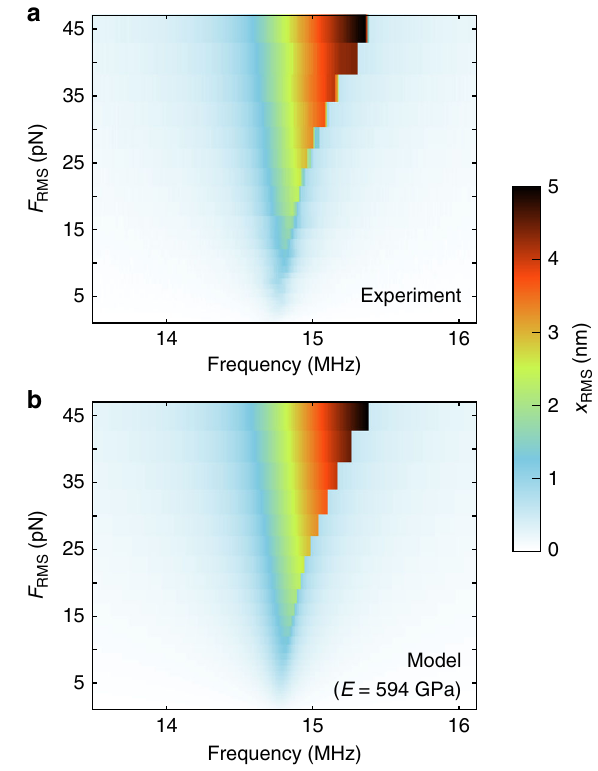
Fig. 1). Using Eq. (3), the nonlinear ð 4 Þ Fig. 3 Comparison between the measured and the modeled response. Comparison of the RMS motion amplitude ( x RMS ) between experiment ( a ) and model ( b ) using the fi tted value for the Young ’ s modulus ( E = 594 GPa) for the device shown in Fig. 1 (device 1) force – de fl ection measurement, taken at the center of the drum, is plotted in Fig. 4 (black dots). The curve is fi tted by the AFM force – de fl ection equation given in Table 1, yielding E = 591 GPa and n 0 = 0.093 N m − 1 (red curve in Fig. 4). The blue curve shows